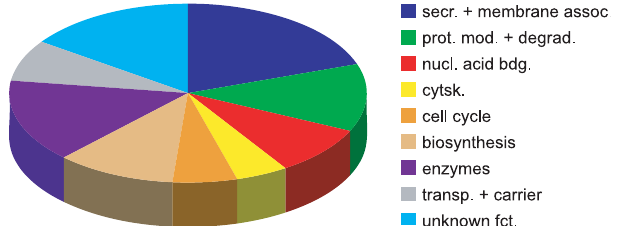
Figure 2. Schematic Representation of the Classification of the 66 Identified Candidate Genes into Functional Groups The affiliation of the genes products is indicated by the color and the size of the fragments represents the quantitative distribution. cytsk., cytoskeleton; nucl. acid bdg., nucleic acid binding; prot. mod. þ degrade., protein modification or degradation; secr. þ membrane assoc., secreted or membrane-associated factors; transp. þ carrier, transporter or carrier; unknown fct., unknown